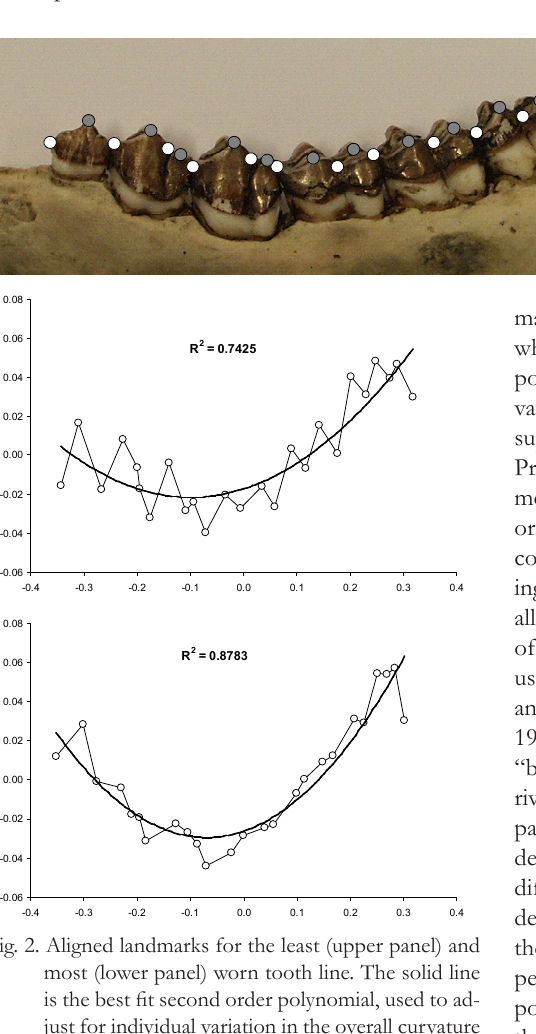
Fig. 1. The landmarks used for assessing dental wear are shown in white for fixed landmarks (valleys) and in grey for sliding semi-land- marks (cusps).